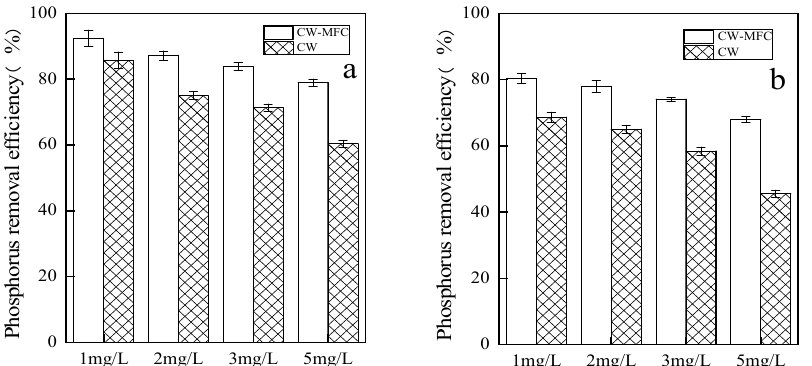
Figure 2. Phosphorus removal by the CW and CW-MFC systems. ( a ) Constructed system based on garnet; ( b ) constructed system based on magnesia.